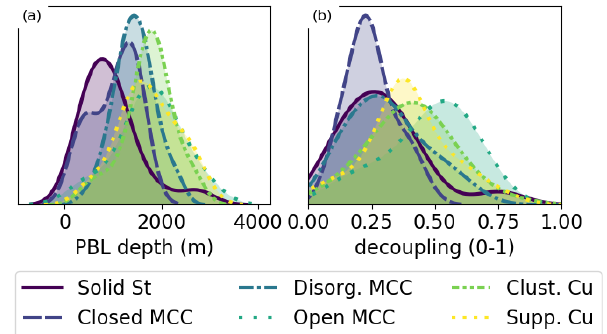
Figure 10. Histograms of (a) boundary layer depth and (b) bound- ary layer decoupling index from CSET flights and dropsonde obser-